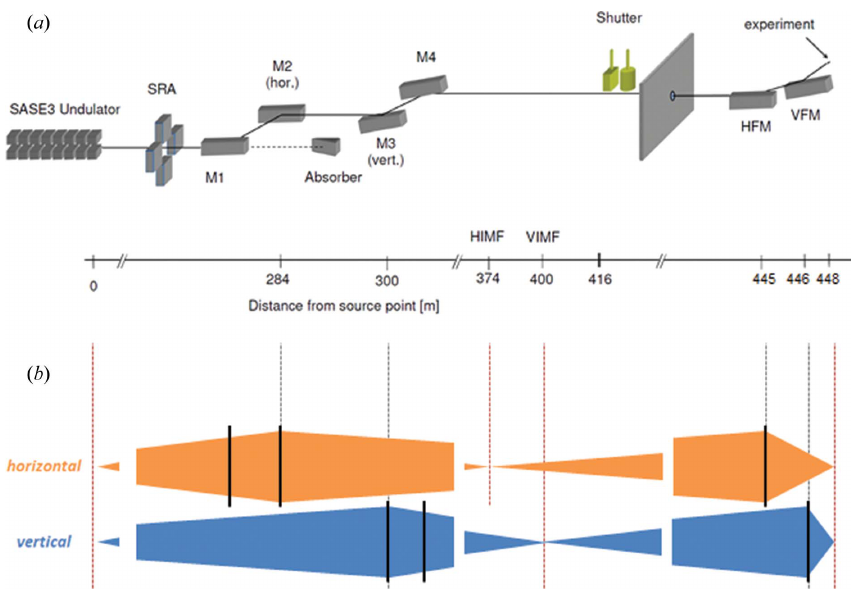
Figure 1 ( a ) Schematic representation of the beam transport layout of the SQS branch of the SASE3 beamline (Tschentscher et al. , 2017), which is described in detail in the text. The distance of each optical element to the source point is given at the bottom of the scheme. ( b ) The beam propagation conditions are schematically represented for both the vertical and the horizontal directions. The beam diverges from the source point until it reaches the first focusing element, which is M2 in the horizontal and M3 in the vertical direction. The beam converges horizontally and vertically on two different positions along the beamline, labeled HIMF and VIMF (horizontal and vertical intermediate focus, respectively), located at 90 m and 100 m distance from the respective mirrors. These positions are then the virtual sources imaged by the HFM (horizontal focusing mirror) and VFM (vertical focusing mirror) into the focal position where the experiment takes place. The dashed vertical lines indicate the position of the focusing mirrors and of the (virtual) sources and images in the vertical and horizontal